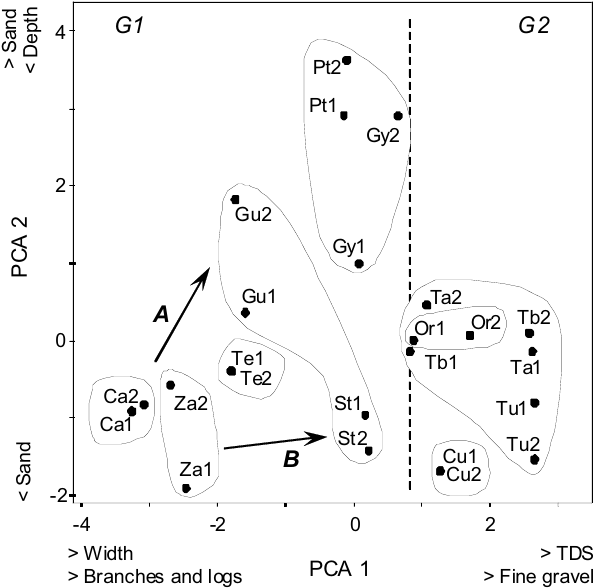
> TDS > Fine gravel